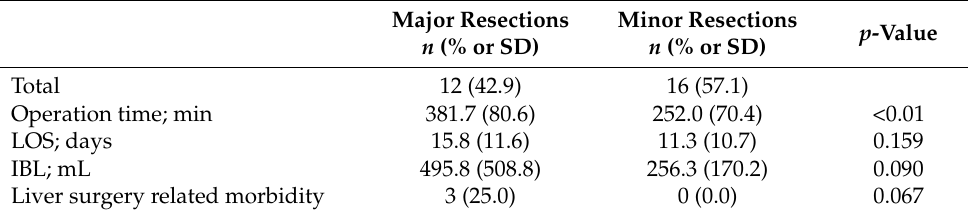
Table 4. Perioperative outcomes between major vs. minor robotic liver resections (RLR) using the three device (3D) technique for parenchyma